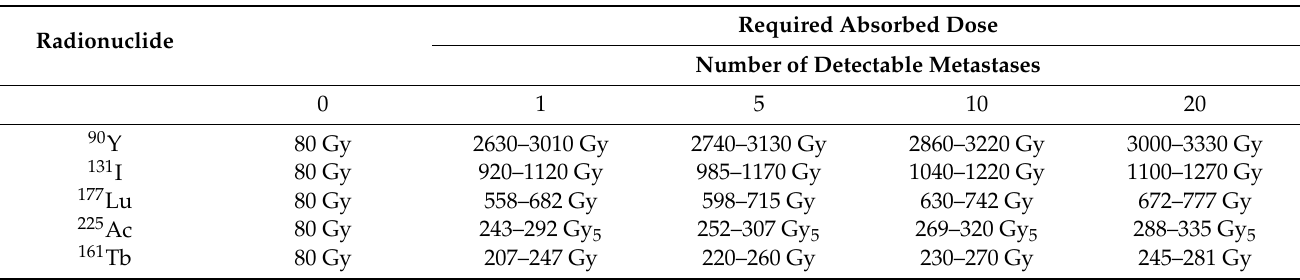
Table 4. The range of the required absorbed tumor dose for obtaining MCP = 0.99 at different metastatic formation rates and its corresponding number of detectable metastases. The radiosensitivity α was set to 0.147 and TNC set to 100. For actinium-225, a weight of 5 was used in the calculation of the required absorbed dose; indicated with the unit “Gy 5 ”. Radionuclide